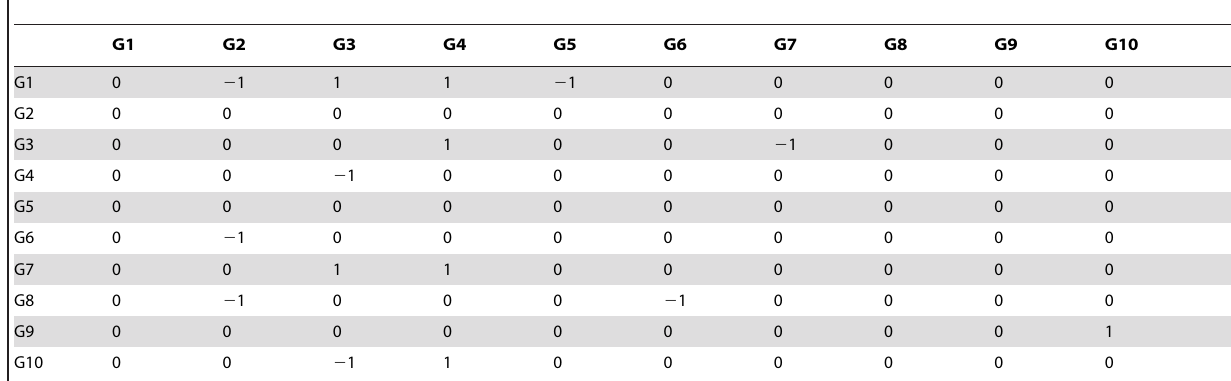
Table 4. Connection matrix of the first gold standard network in Dream 4